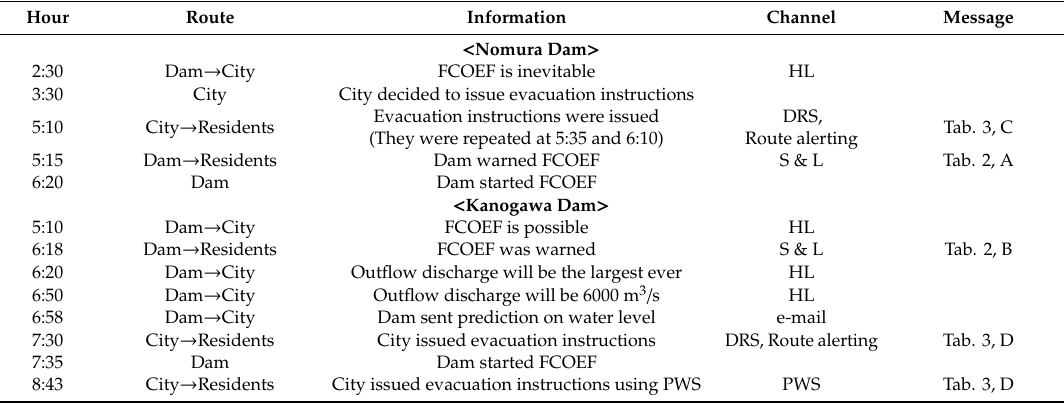
Table 1. Information provided by the dam operator and its response of local government. Constructed from MLIT a [22].